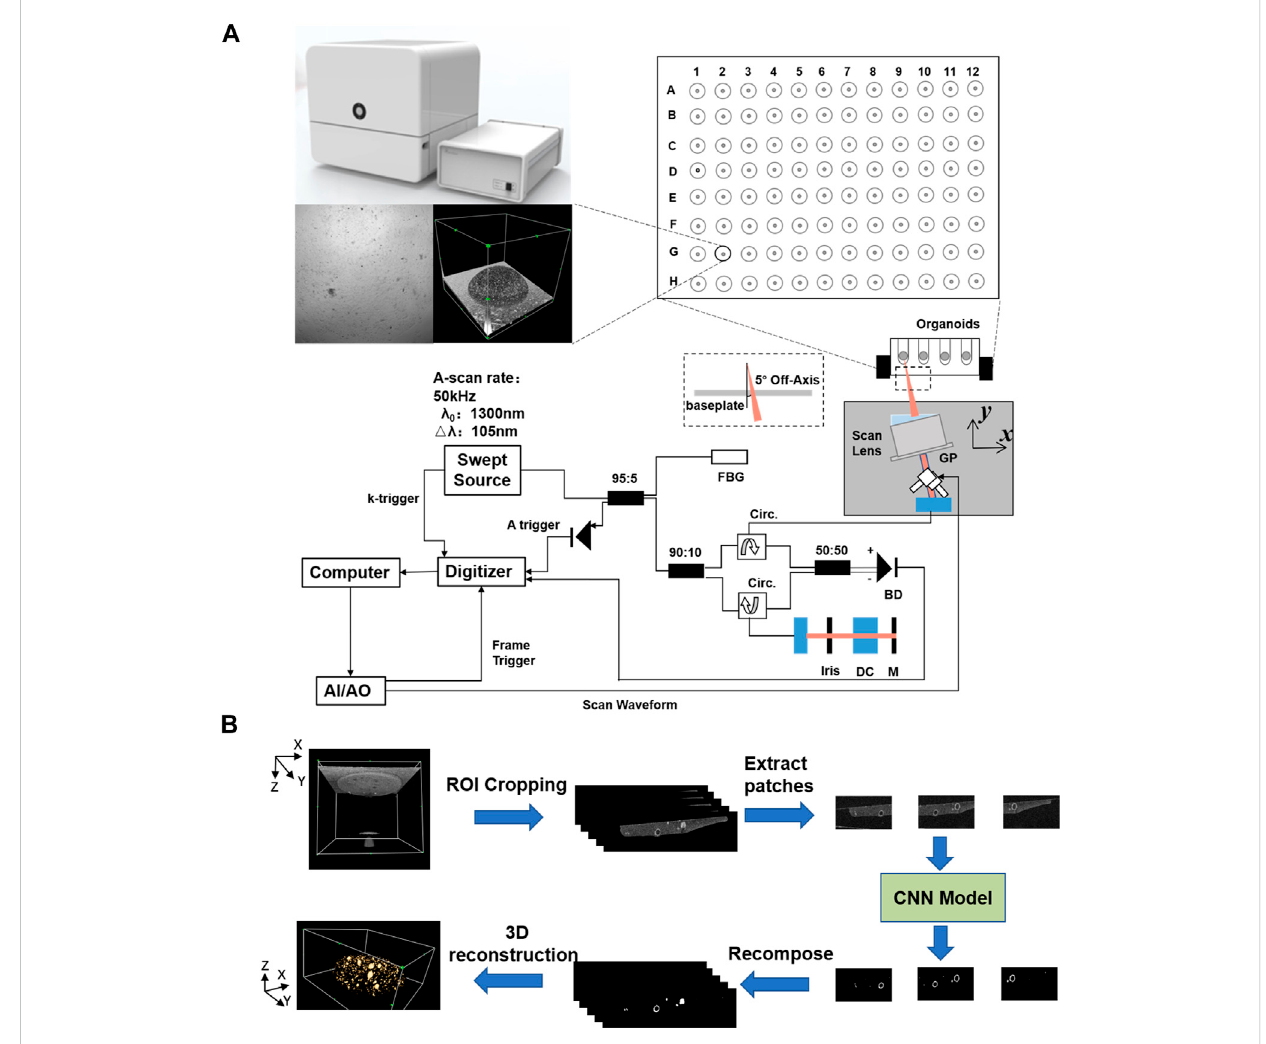
FIGURE 1 Schematicdiagram of the SS-OCT system and thedata processing fl owchart for organoidimaging and segmentation. (A) Schematicdiagram of the SS-OCT system for organoid imaging, (B) The data processing fl owchart for organoid segmentation.